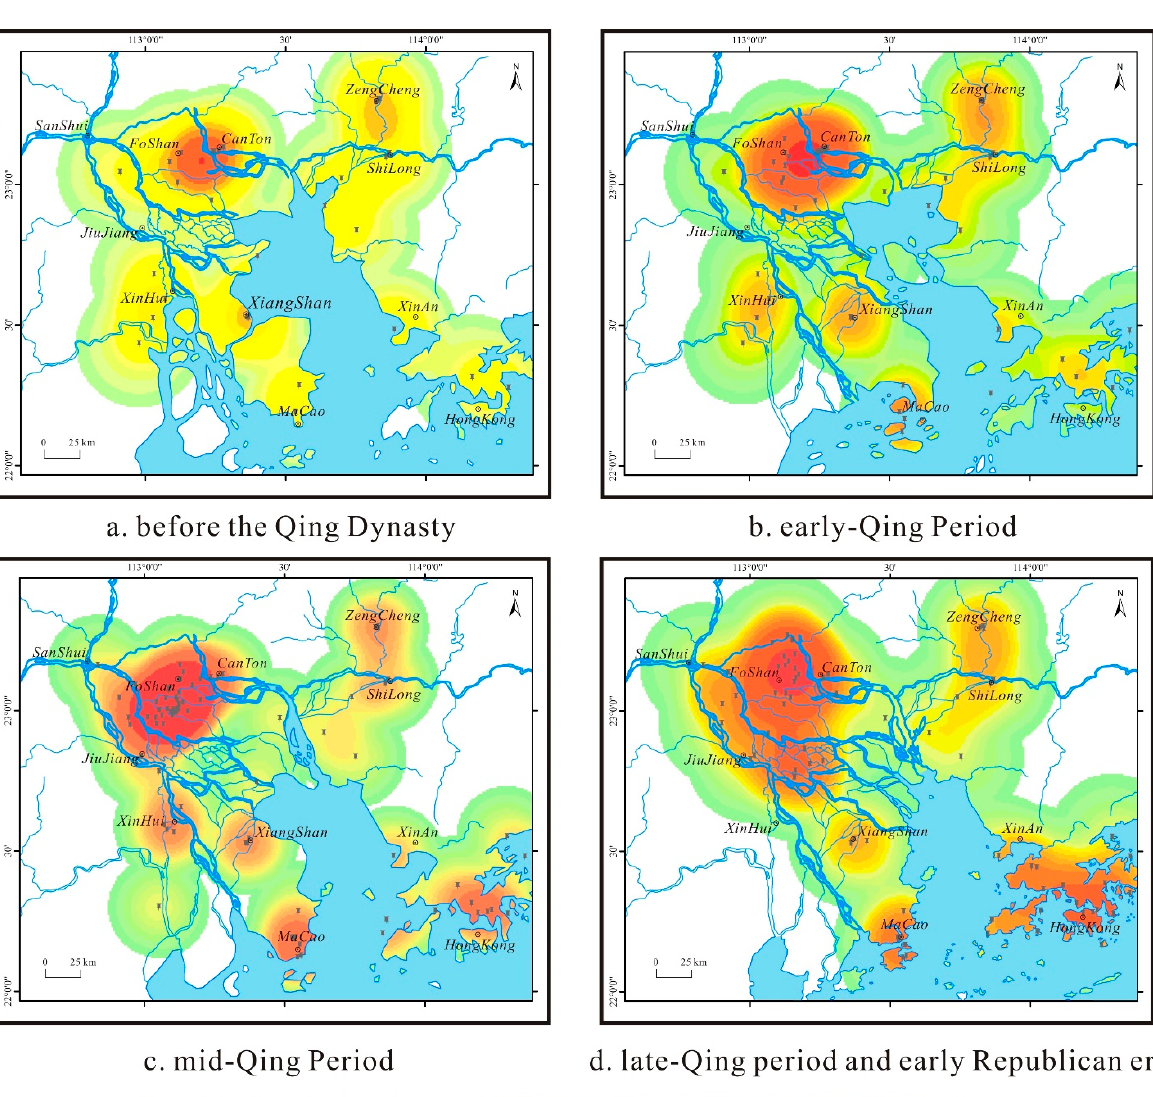
Figure 4. The process of the spatiotemporal evolution of Tianfei Belief.